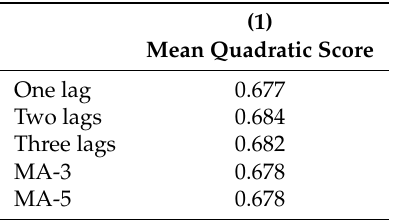
Table A1. Information Vector Definitions.